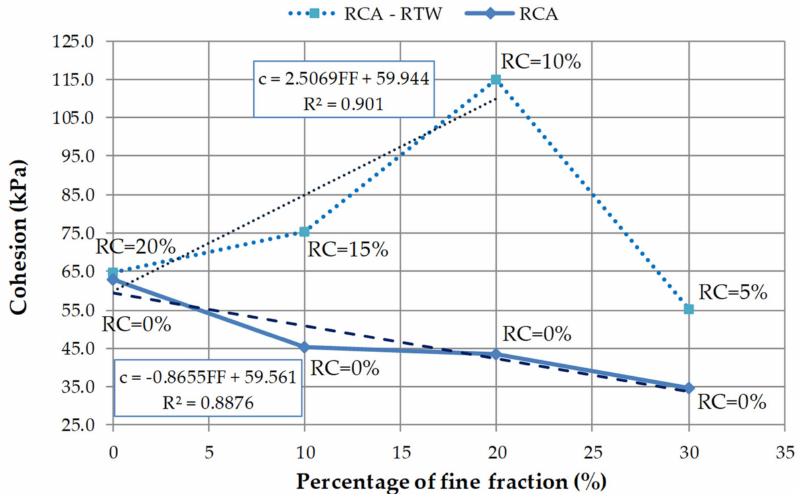
Figure 11. The relationship between cohesion and fine fraction of RCA and RCA–RTW mixtures. Note: RC—rubber